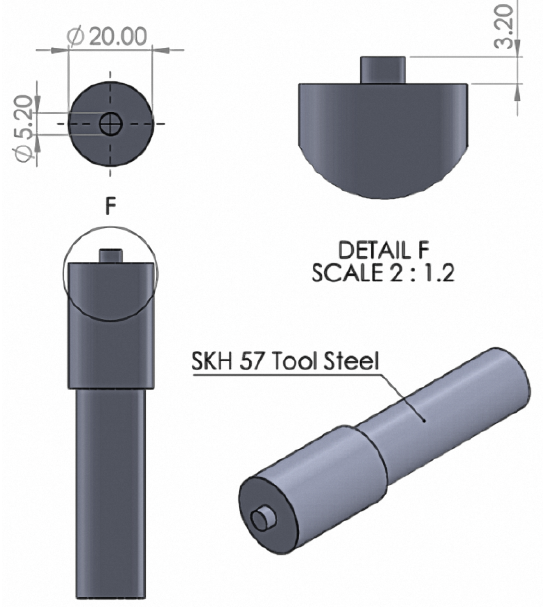
Figure 3. The geometry and dimensions of welding tool created using the FSSW process.